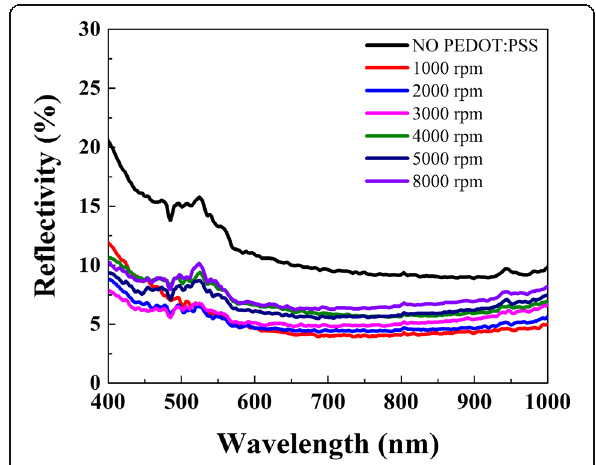
Fig. 6 The reflectance curves of textured Si coated with PEDOT:PSS layer at different coating rates from 1000 to 5000 rpm, 8000 rpm, and no PEDOT:PSS